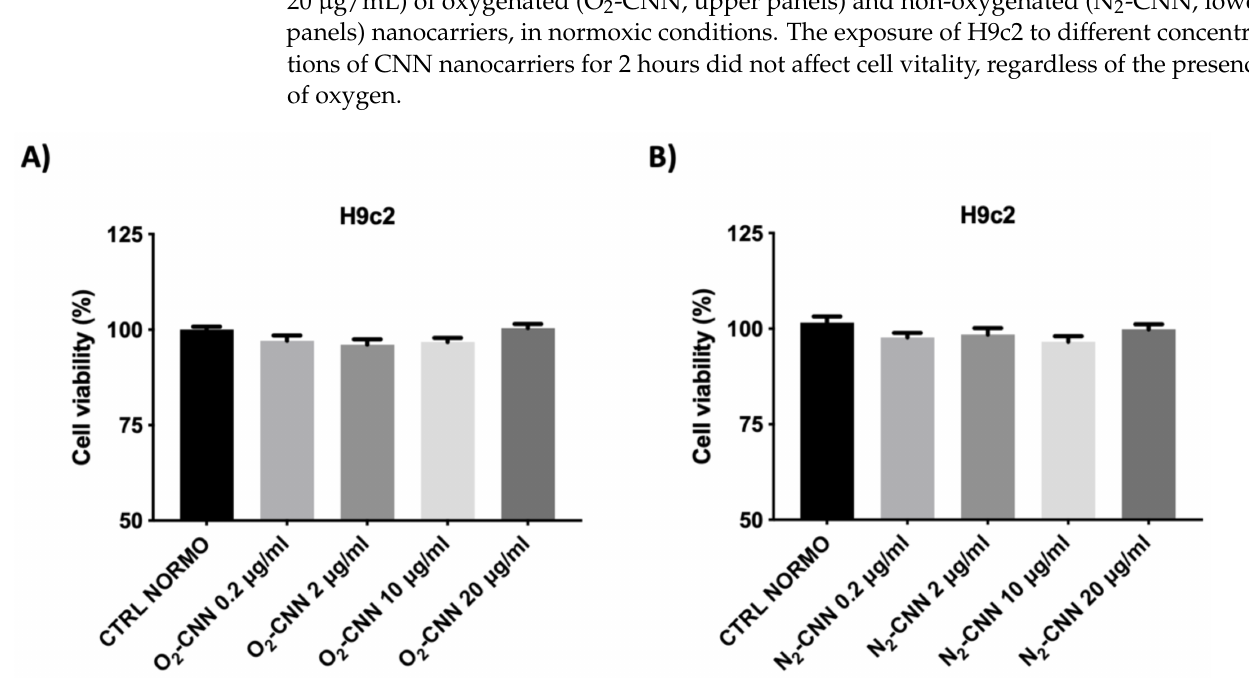
Figure 4. Dose–response of H9c2 in normoxic conditions. ( A ): Treatment with O 2 -CNN (0.2, 2, 10, and 20 µ g/mL) compared to the untreated control group (CTRL). ( B ): Treatment with N 2 -CNN (0.2, 2, 10, and 20 µ g/mL) compared to the untreated control group (CTRL). Data were expressed as mean ± SE. Data were normalized to the mean value under control conditions (CTRL NORMO) and expressed as a